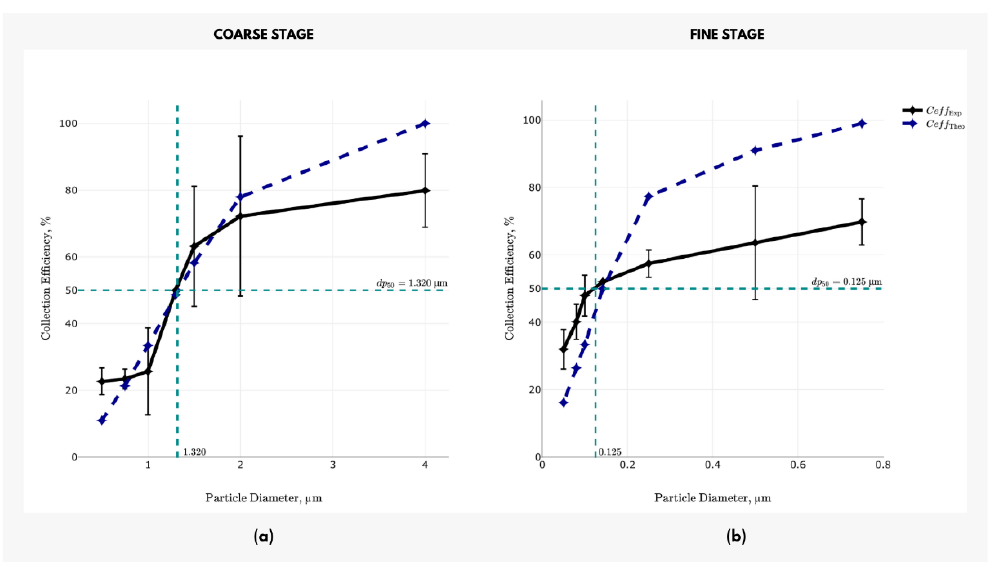
Figure 5. Theoretical (blue dotted line) and experimental (black line) collection efficiency curves for the coarse ( a ) and fine ( b ) stages (Error bars = 1 S.D with n = 5 for the coarse stage and 3 S.D with n = 5 for the fine stage).